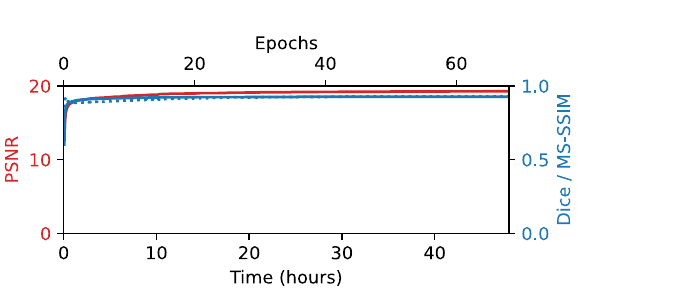
Figure 7. Accuracy metrics (PSNR, Dice, and MS-SSIM) for reconstructions of the central slice of the foam phantom, using cycloidal subsampling with an MS-D network at various points during the 48 hour training